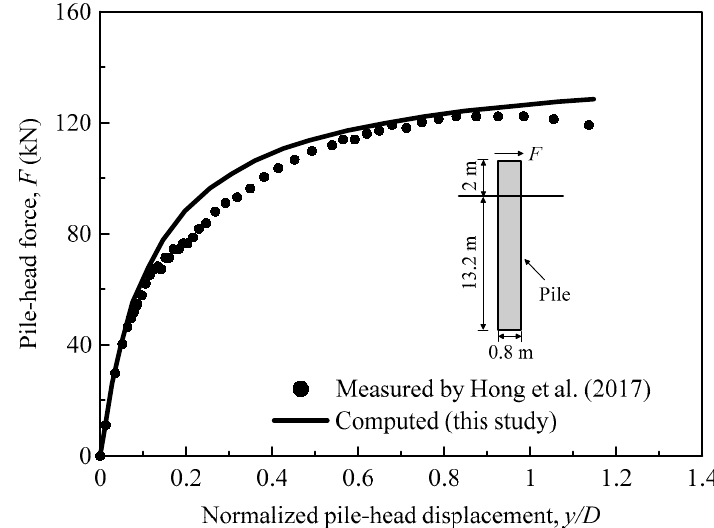
Figure 4. Validation of the numerical model against the centrifuge test reported by Hong et al. [35].